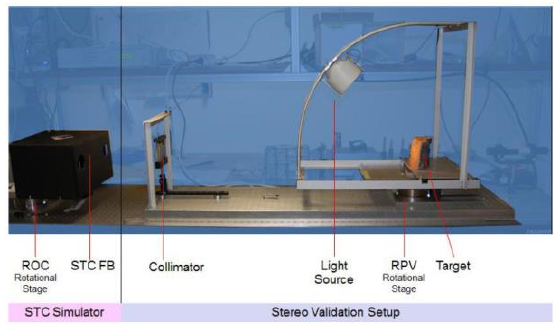
Figure 7: Experimental Setup for STC validation.